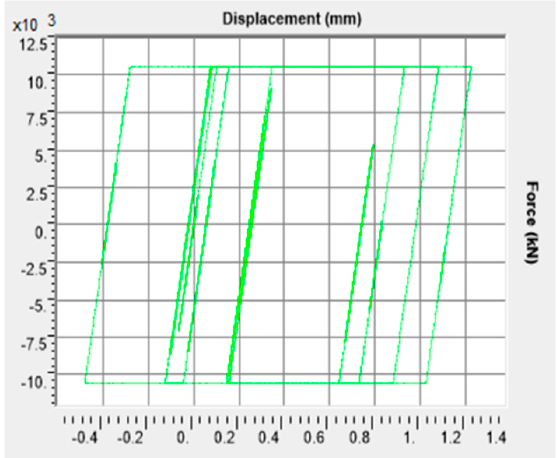
Figure 10. Hysteresis curve for whole building with slab model at 11th storey for IHC model in the ULS case. The THC f